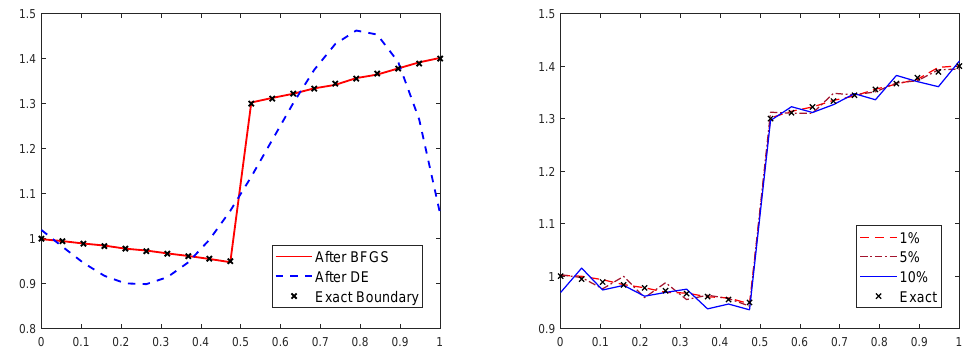
Figure 4. Results for example 3 without noise ( left ), with different noise level ( right ).